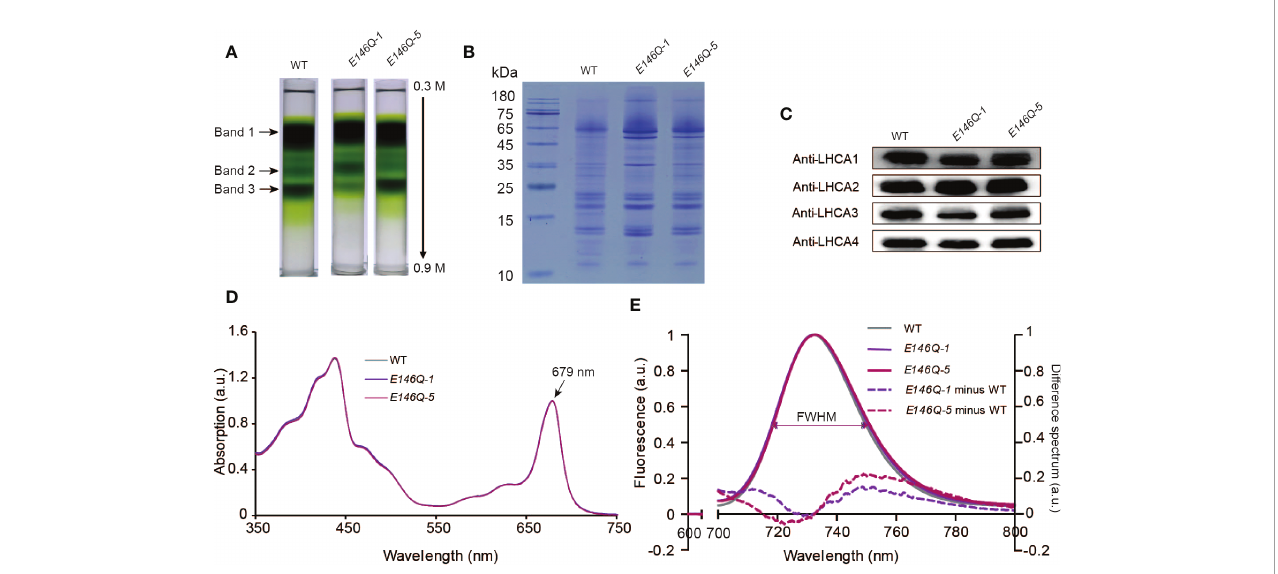
FIGURE 6 Isolation and characterization of PSI-LHCI from 35S:LHCA4 ( E146Q ) point mutant plants. (A) Sucrose density gradient (0.3 – 0.9 M) ultracentrifugation of thylakoid membranes isolated from WT and 35S:LHCA4 ( E146Q ) point mutant lines. Samples corresponding to 0.5mg Chls were loaded onto each tube, and three major bands were separated. (B-C) Polypeptide composition of PSI-LHCI from the WT and 35S:LHCA4 ( E146Q ) lines analyzed by Coomassie staining following SDS-PAGE (samples corresponding to 2.5 m g Chl were loaded per lane). (B) and immunoblot analysis (C) with antibodies against LHCA1, LHCA2, LHCA3, and LHCA4. (D) Absorption spectra of PSI-LHCI complexes isolated from the WT and 35S:LHCA4 ( E146Q ) lines. The spectra were normalized to their maximal absorption in the Qy region, which was set to 1. (E) Low-temperature (77K) fl uorescence emission spectra (excited at 440 nm) of PSI-LHCI complexes isolated from the WT and 35S:LHCA4 ( E146Q ) lines. The spectra were normalized to their emission maxima (set to 1), with their FWHMs labeled and shown as double arrows in the same colors as the spectra. The dotted lines show the difference between the spectra from 35S: LHCA4 ( E146Q ) -1 and the WT (light purple line) or 35S:LHCA4 ( E146Q ) -5 and the WT (dark line) and multiplied by 5 to facilitate